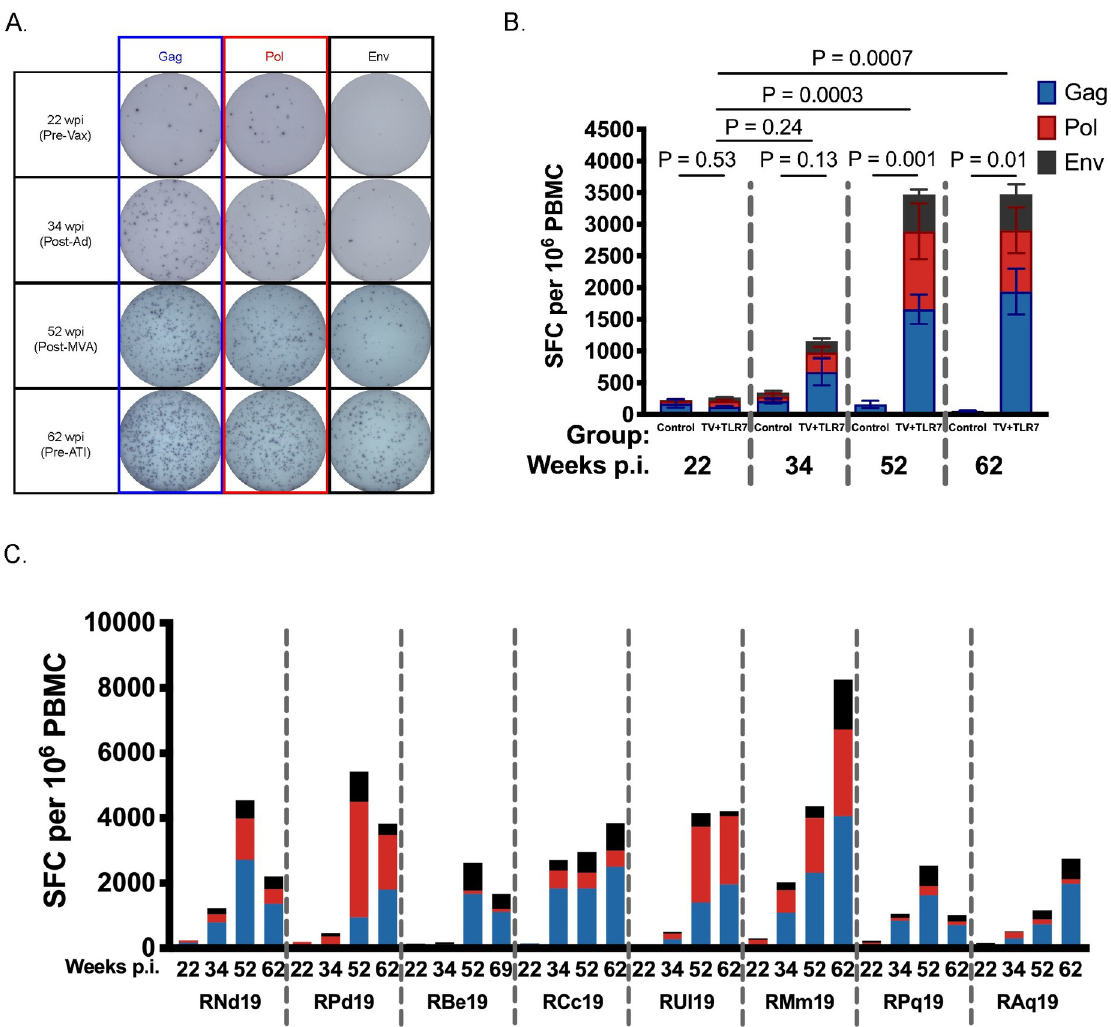
Fig 2. Cellular response measured by ELISPOT to therapeutic vaccination in SIV-infected, ART-treated infant RMs. (A) Representative images of spot forming cells (SFC) in response to Gag, Pol, and Env at timepoints indicated above. Wpi, weeks post infection. (B) IFN- γ ELISPOT responses to Gag, Pol, and Env peptide pools from SIV mac239 were measured at week 22 prior to vaccination, week 34 after priming with two doses of Ad48, week 52 after boosting with two doses of MVA, and week 62 prior to analytical treatment interruption in control RMs (n = 4) and TV+TLR7 (n = 8) RMs. Bars represent mean ± SEM. Statistical analysis was performed to compare with week 22 using the non-parametric Friedman test with Dunn’s multiple comparison test to correct for multiple comparisons. (C) Individual IFN- γ ELISPOT responses of TV+TLR7